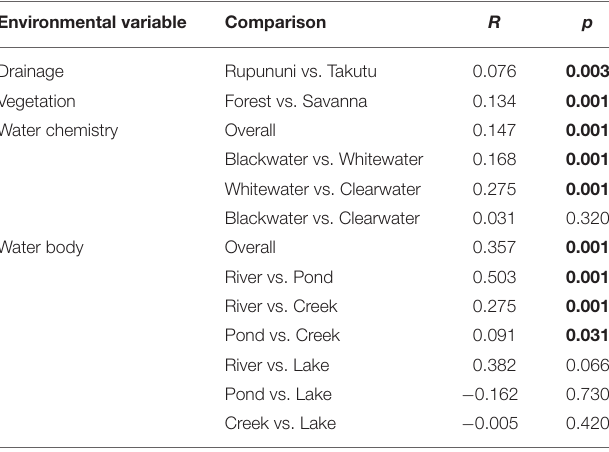
TABLE 2 | Comparisons of the importance of environmental variables of fish assemblage structure. Environmental variable